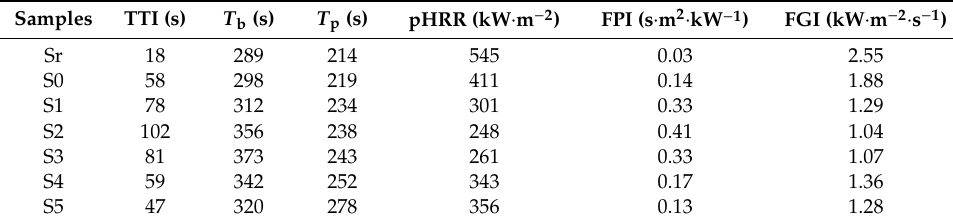
Table 2. Combustion parameters of samples tested by cone calorimeter (CC).